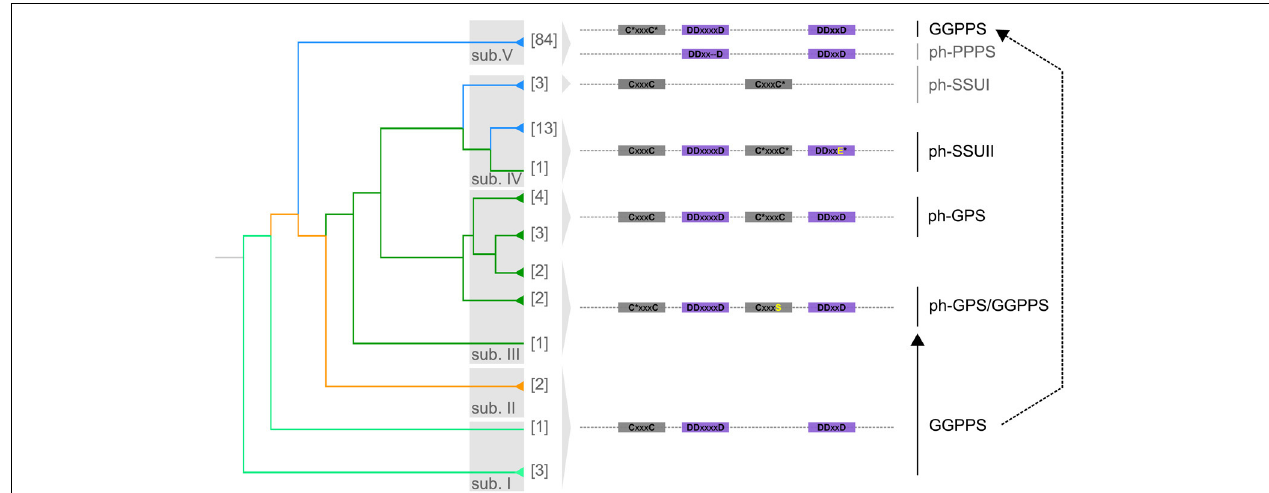
FIGURE 2 | Molecular evolution of the polyprenyl synthase domain. The summarized phylogenetic tree of GGPPS from plants is shown. Branches holding more than one homolog are collapsed and the number of homologs is shown. The five classes (sub. I–V) of GGPPS homologs in plants are shown. Branch colors represent the major plant lineages: spring green, green algae; orange, mosses; dark green, gymnosperms; and blue, angiosperms. The representative polyprenyl synthase motifs for each of the five classes are shown: the two CxxxC motifs in gray and FARM, SARM in purple. Asterisk ( ∗ ) indicates variable amino acid residues ( Supplementary Figure 1 and